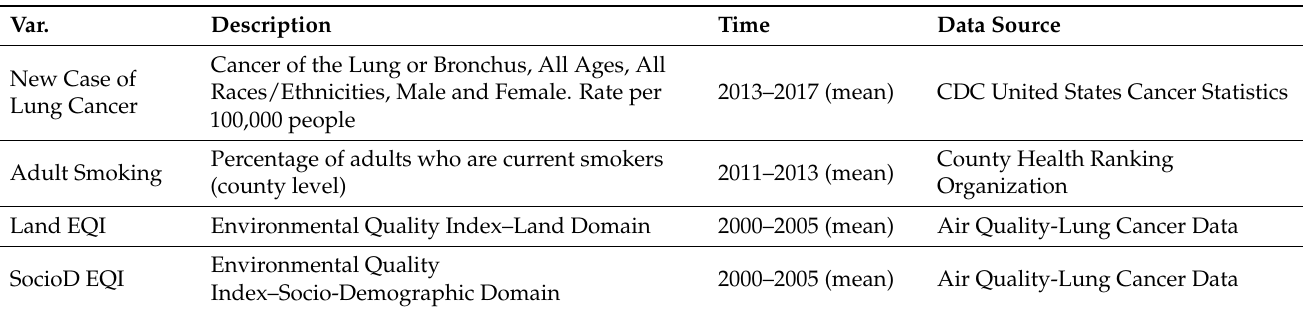
Table 2. Variables and their Descriptions, Timeframe, Data